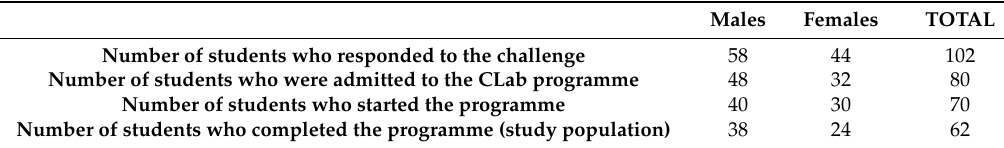
Table 2. Number of males, females and the total students who (i) responded to the challenge, (ii) were